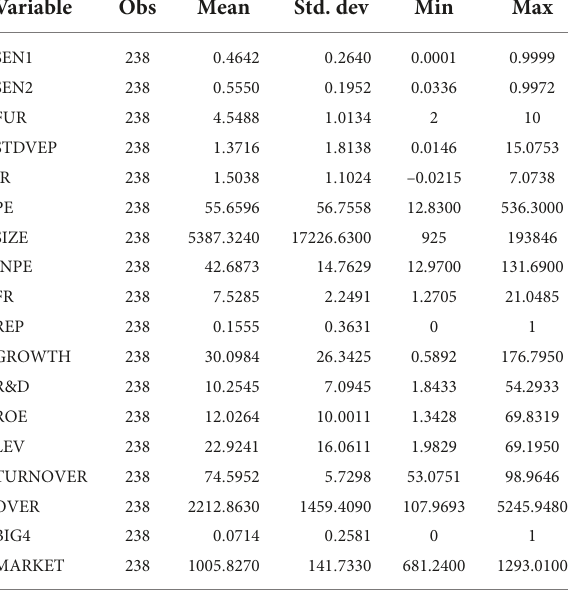
TABLE 4 Regression results of media sentiment on IPO pricing efficiency and IPO first-day